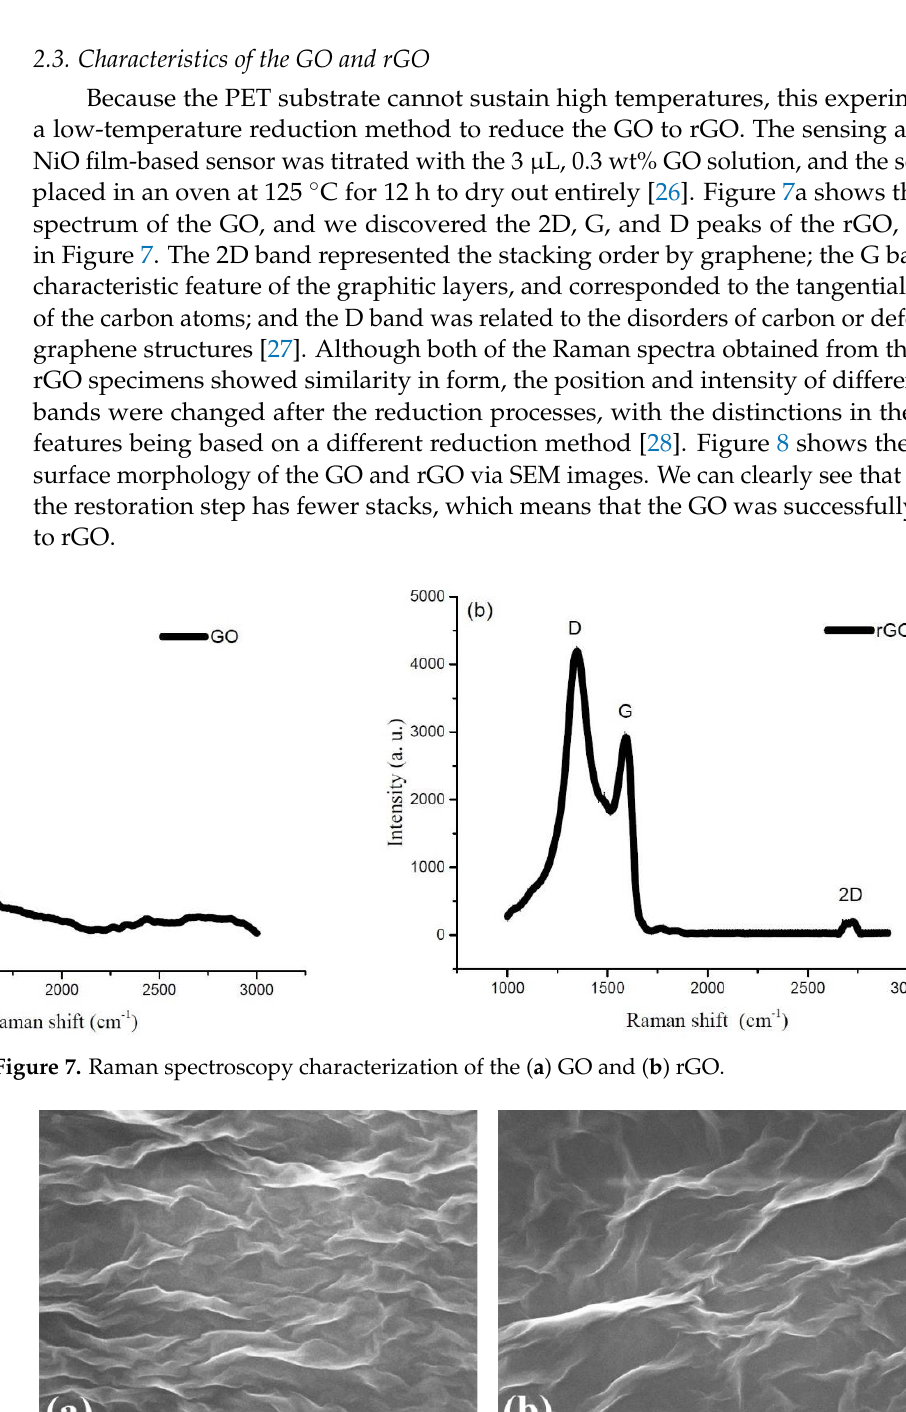
Figure 6. UV – Vis extinction spectra of the optical characteristics of the AgNW solution.